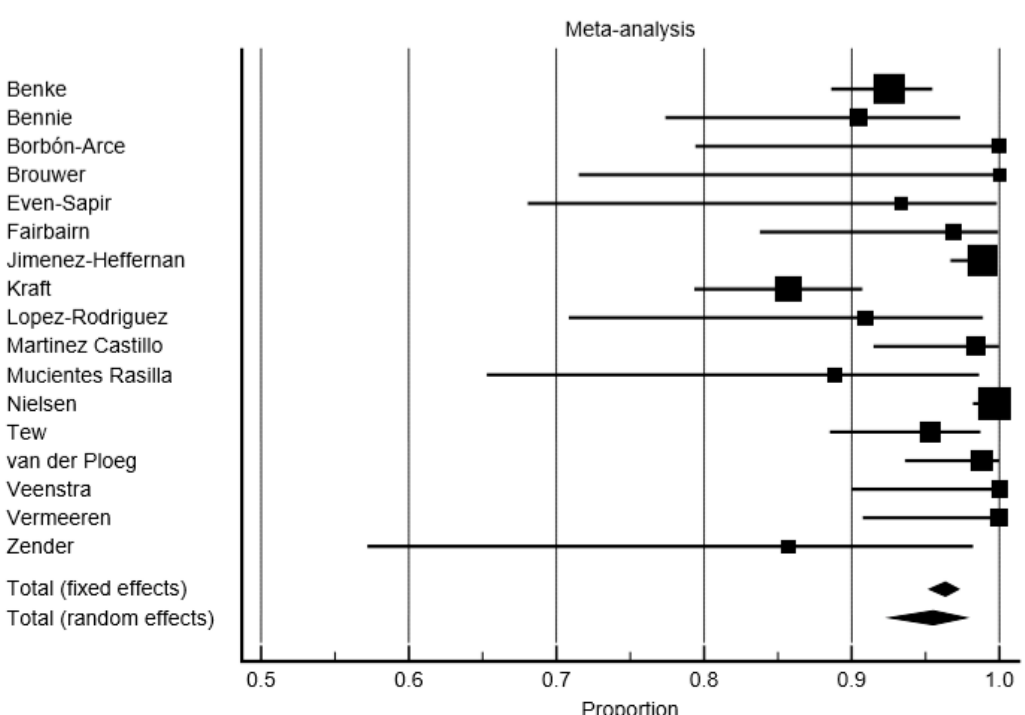
Figure 4. Forest plot of the detection rate (DR) of the sentinel lymph nodes (SLNs) on planar lymphoscintigraphy (PL).